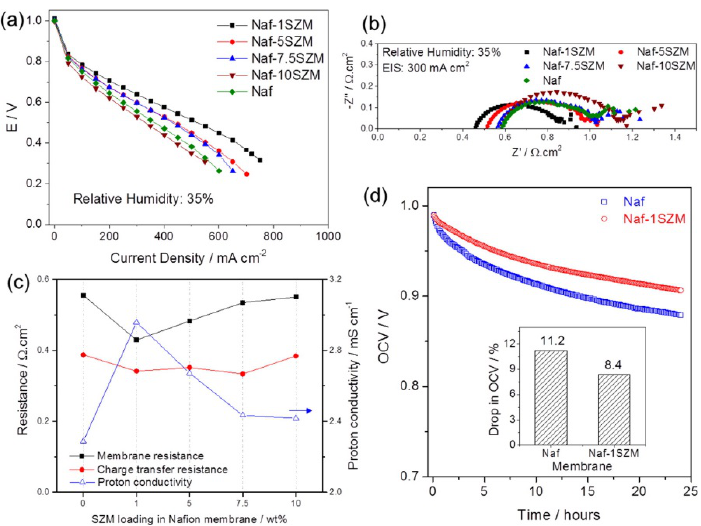
Figure 10. Polarization curves ( a ). Nyquist plots obtained with EIS ( b ), membrane resistances, proton conductivities and charge transfer resistances as a function of the SZM content in the composite ( c ). Stability runs as obtained for 24 h at 35% RH, at 80 °C ( d ). The inset shows the OCP drop in percentage (%). Reprinted with permission from Ref. [61] under a Creative Commons Attribution (CC-BY) License. Copyright 2016 American Chemical Society.